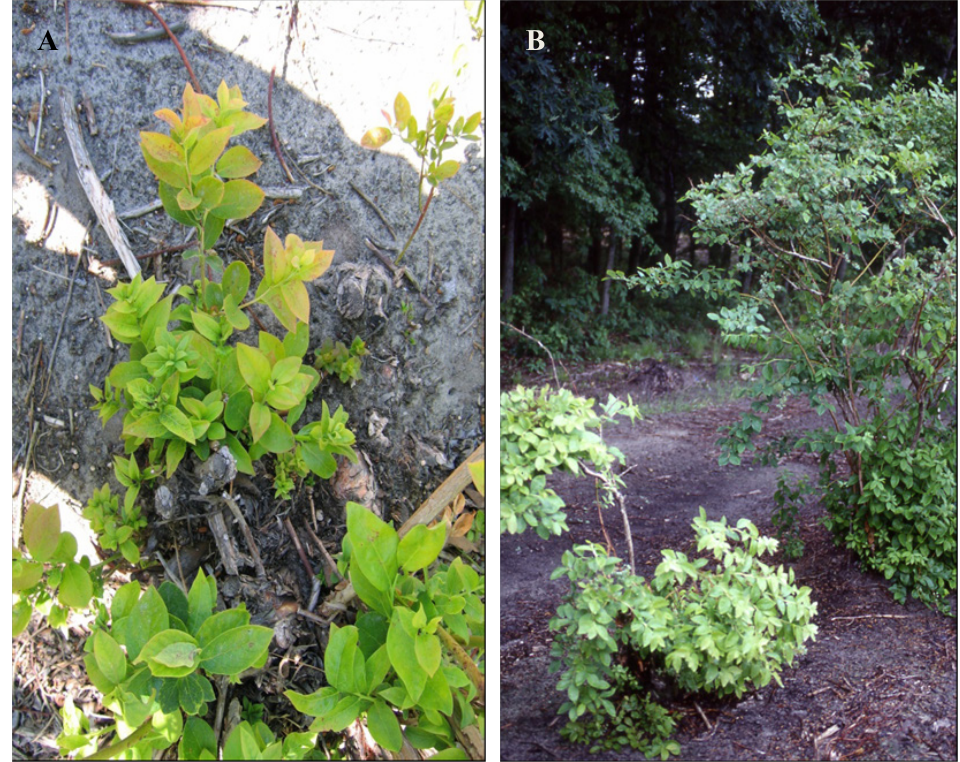
Figure 1. Symptoms of Blueberry leaf mottle virus : ( A ) small, pale green, rosetted and narrow leaves; ( B ) pale green, stunted Jersey bush (on left) (Photos courtesy Annemiek Schilder, Michigan State